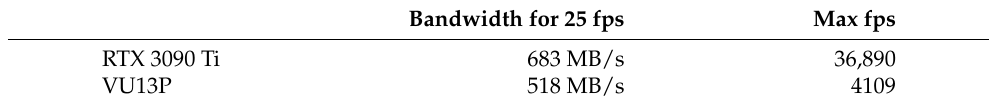
Table 5. Bandwidth of a 25-fps video and maximum achievable fps with the OR